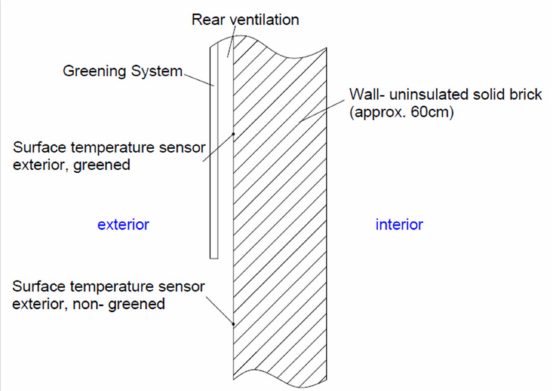
Figure 6. Schematic representation of the measuring positions of the surface temperature on the wall (uninsulated solid brick, approx. 60 cm) with the greening